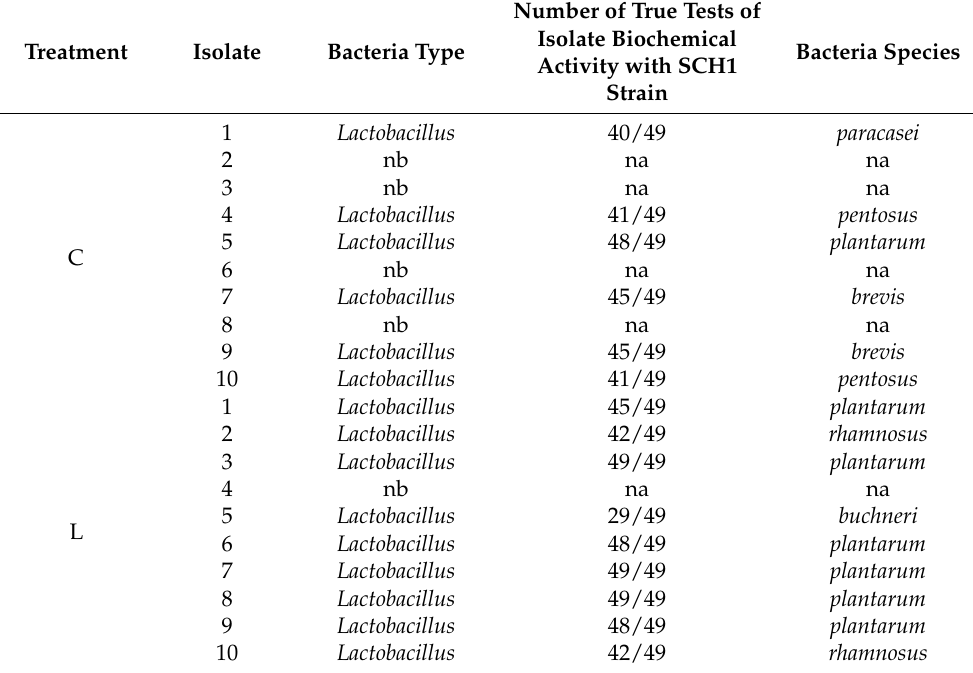
Table 6. Biochemical estimation results of